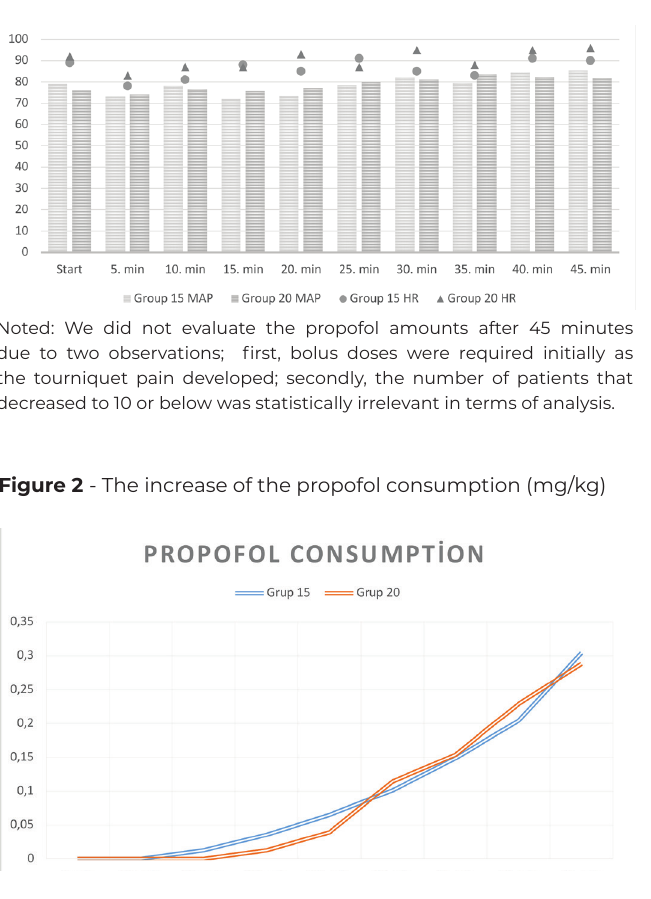
Figure 1 - Distribution of the MAP and HR averages